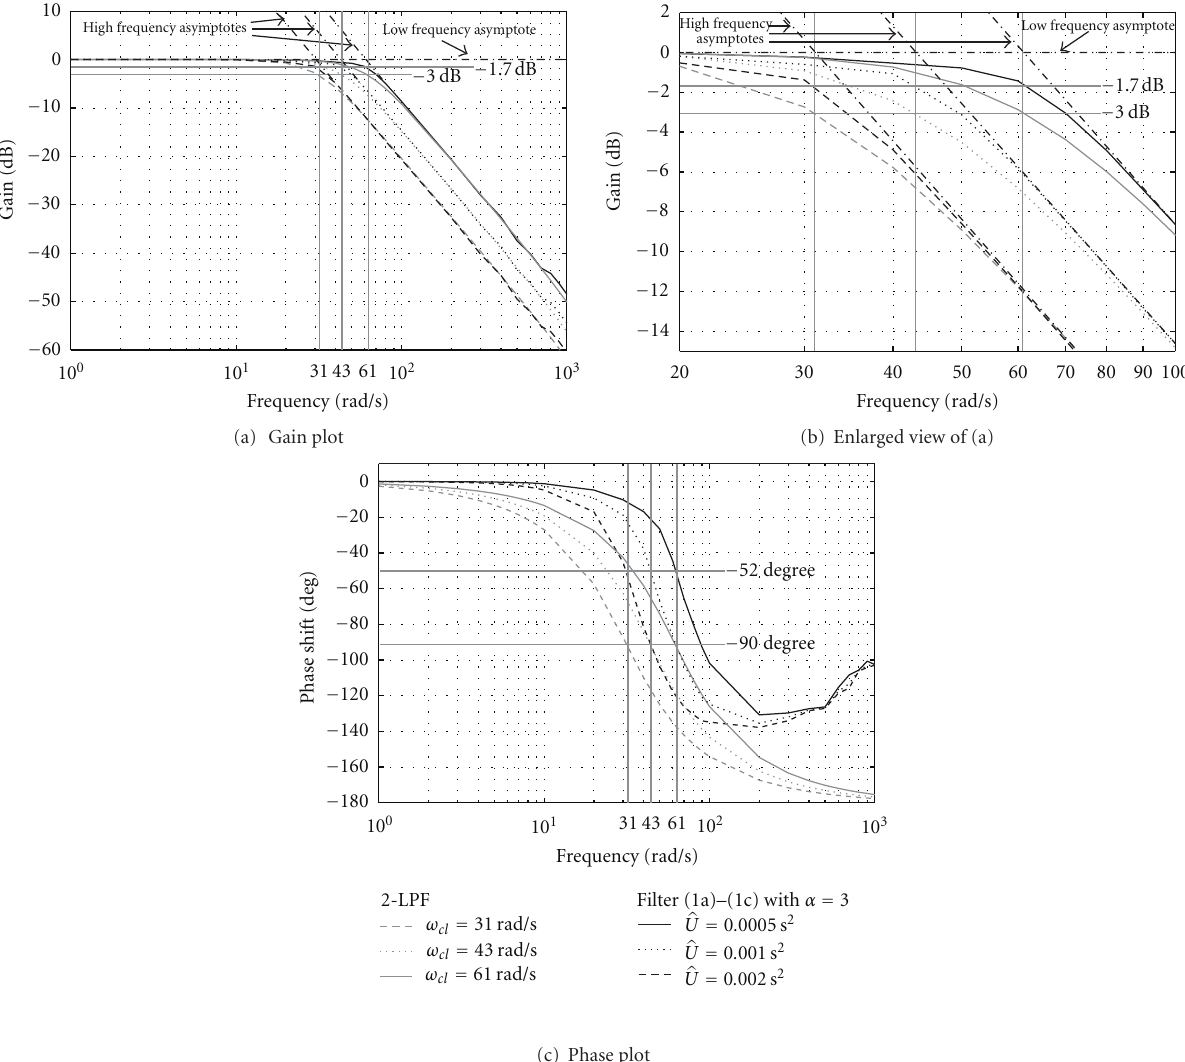
Figure 3: Bode plots for di ff erent values of (cid:8) U